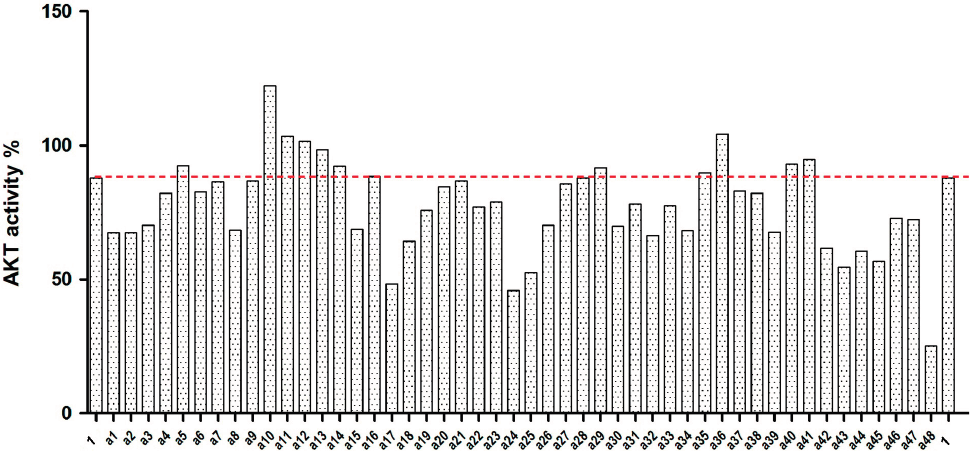
Figure 3. Results for Compounds a1 – a48 from the Akt kinase inhibition assay. H-89 (Compound 1 ) was used as a reference inhibitor in the